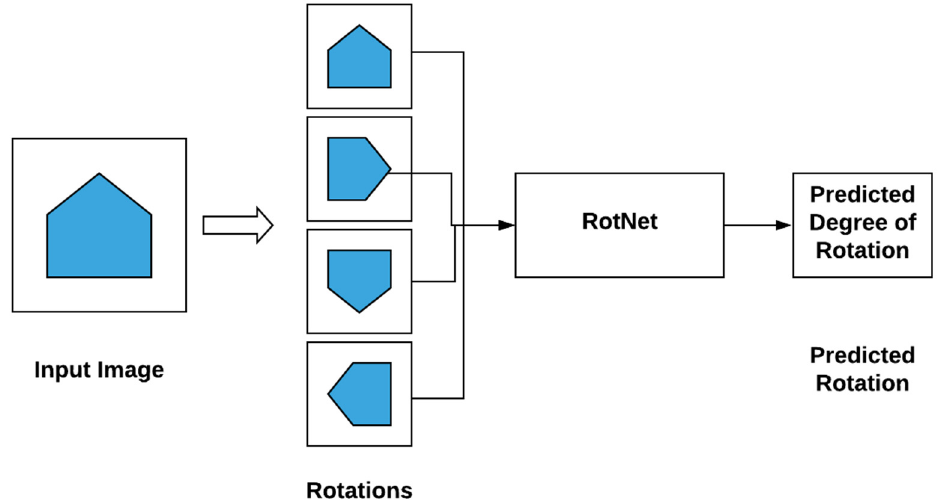
Figure 7. An illustration of the algorithm used in [38]. An input image is rotated by 0, 90, 180, and 270 degrees. A CNN is then tasked with predicting the degree of rotation for an input image.